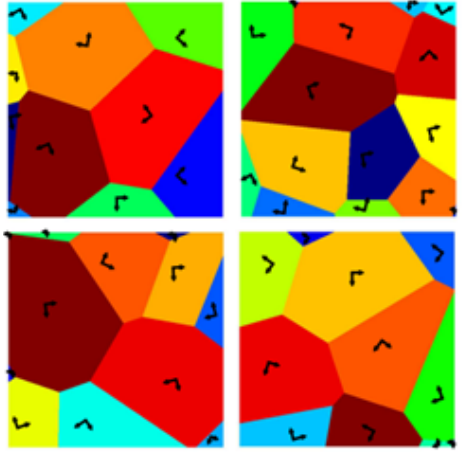
Figure 2. The 2 × 2 µ m 2 SVE examples of the in-plane polycrystalline morphology adopted in the MC